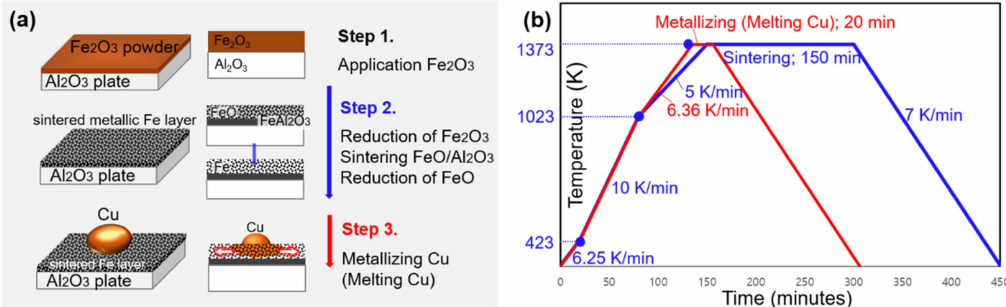
Figure 1. ( a ) Schematic diagram of experimental procedure; ( b ) Heating profiles used in Step 2 (blue line) of simultaneous reduction and sintering of applied Fe 2 O 3 and in Step 3 (red line) of metalizing copper.